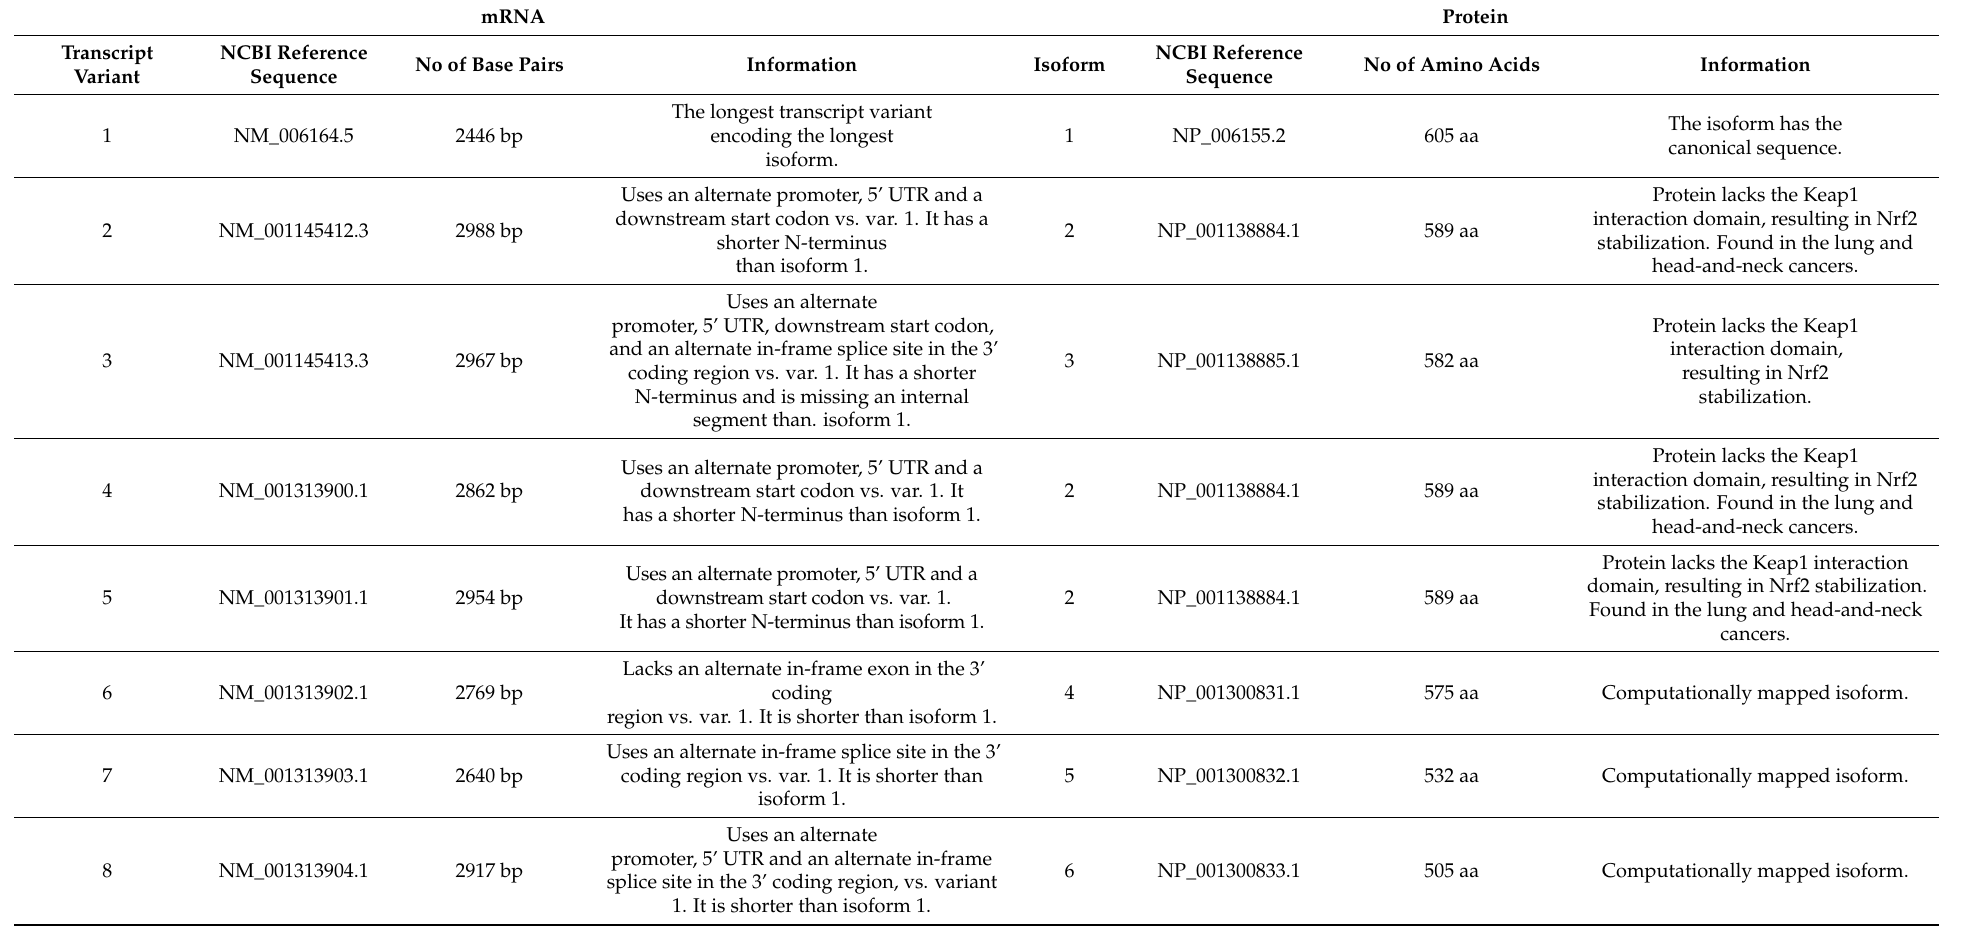
Table 1. List of NFE2L2 transcript variants and encoded protein